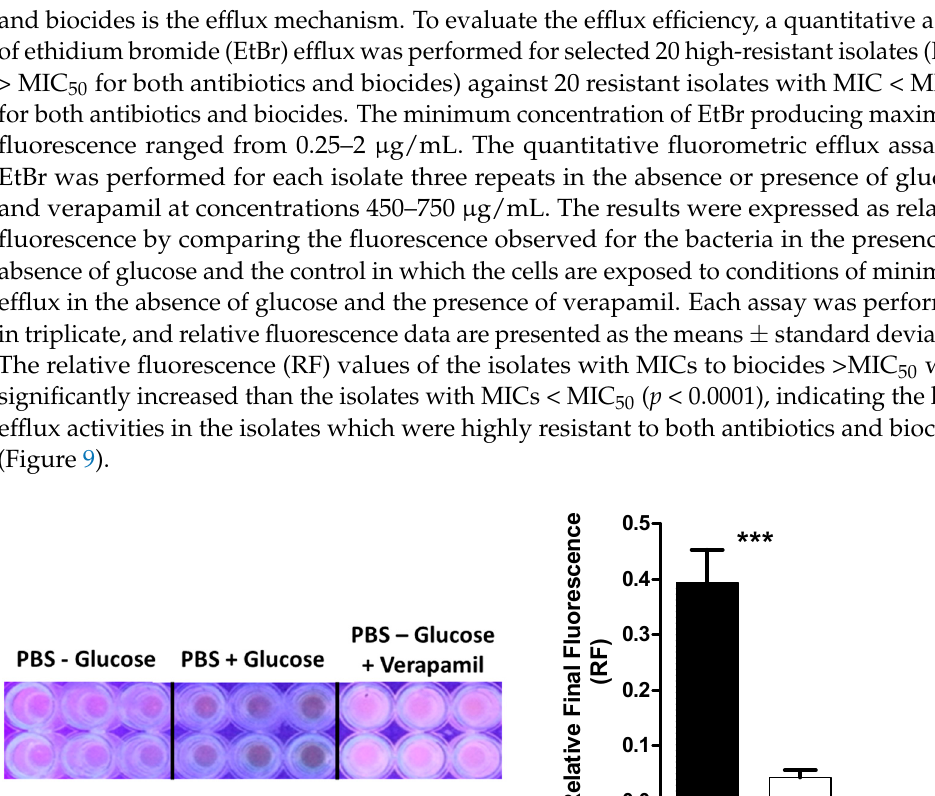
Figure 8. The distribution of MLS genes in the highly resistant isolates that showed MIC ≥ MIC 50 . The efflux encoding genes mefA and mefE were significantly increased in the highly resistant isolates (MIC ≥ MIC 50 ) than in other resistant isolates with MIC < MIC 50 . That could explain the increased role of efflux in resistance to both antibiotics and biocides. * p < 0.05.